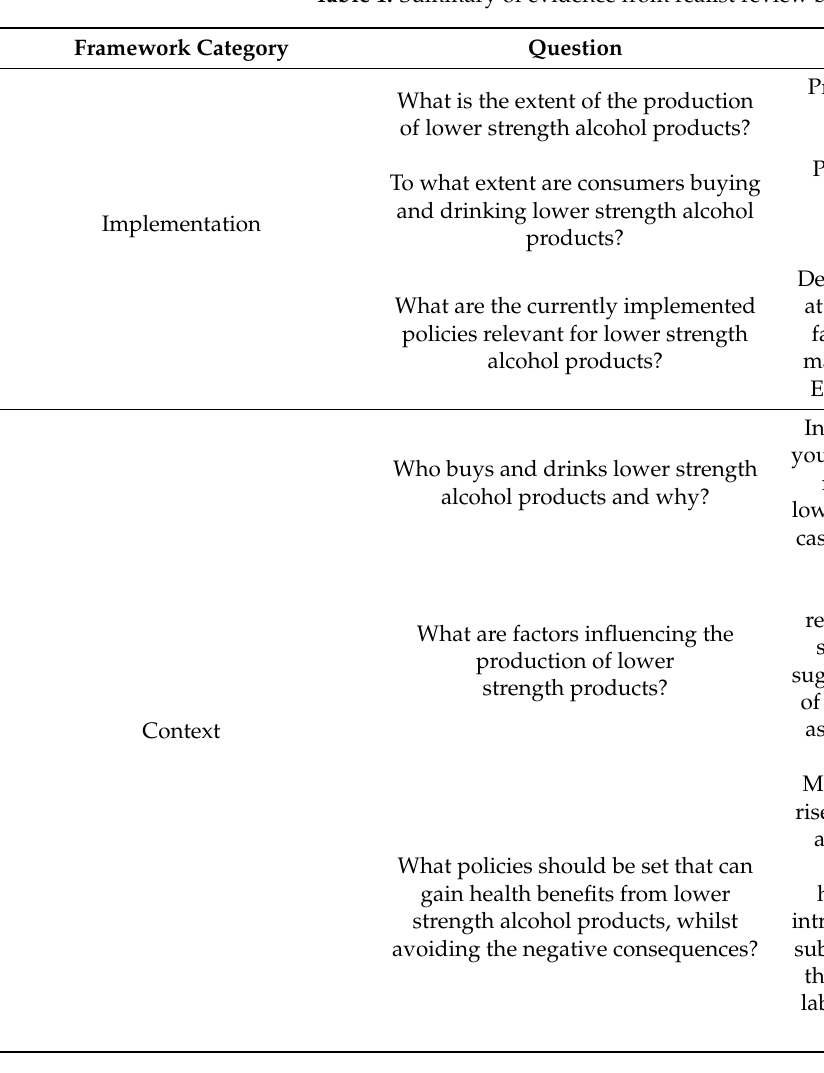
Table 1. Summary of evidence from realist review based on logic model of Figure